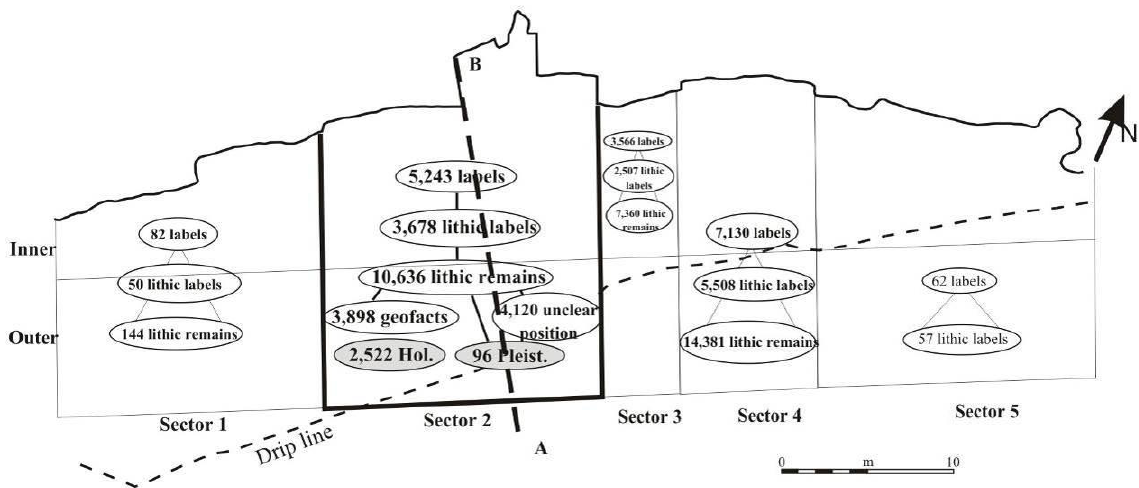
Figure 2 . Site plan with labels and artifacts per sector, comprising both inner and outer